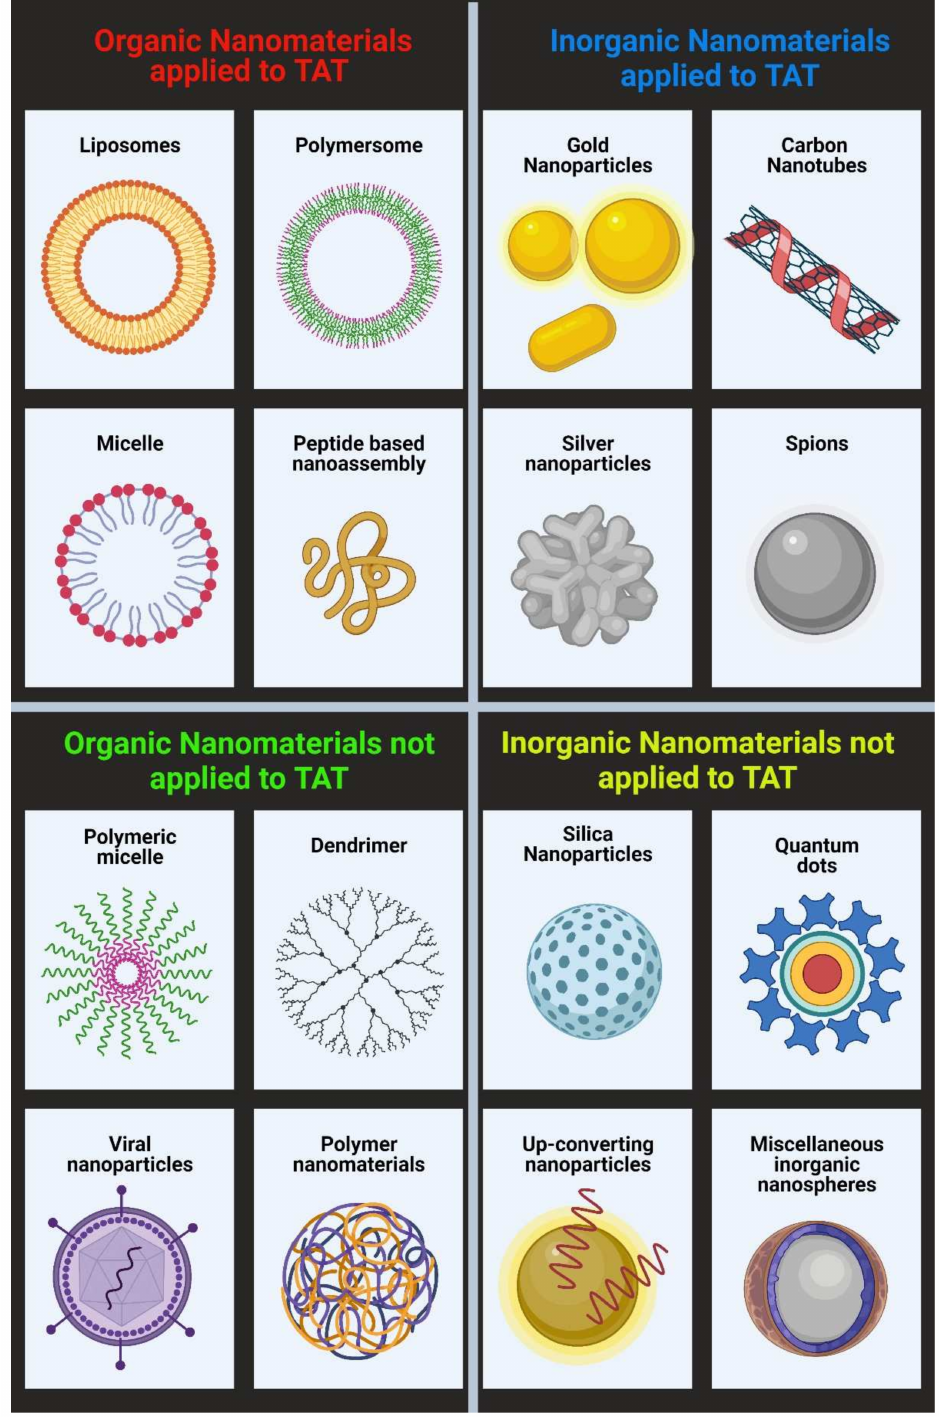
Figure 3. Different types of nanomaterials (non-exhaustive) including examples applied to TAT and examples yet to be applied to TAT (Figure created with BioRender.com (accessed on 12 April